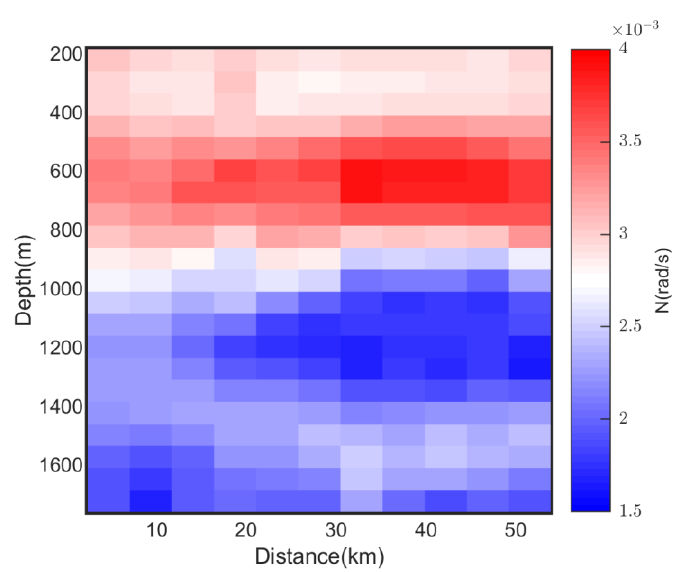
Figure A2. The smoothed buoyancy frequency section estimated from the high-resolution inverted temperature and salinity sections.